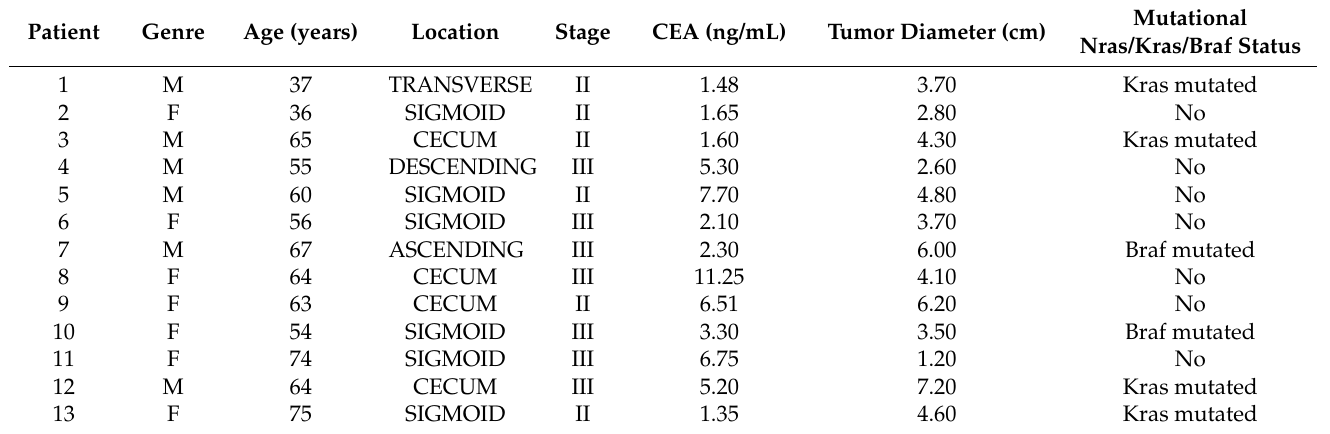
Table 1. Clinicodemographic characteristics of